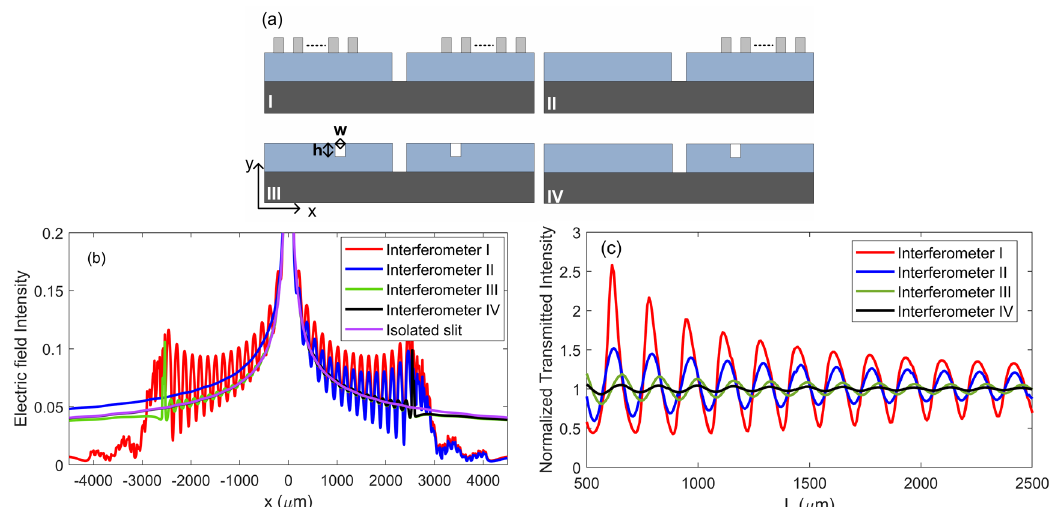
Figure 5. ( a ) Schematic views of four di ff erent interferometers with bilateral Bragg gratings (I), one Bragg grating (II), bilateral grooves (III) and one groove (IV). ( b ) Electric field intensity distributions for four interferometers and isolated slit along upper surface of semiconductor. ( c ) Normalized transmitted intensity versus path length L for four di ff erent interferometers.